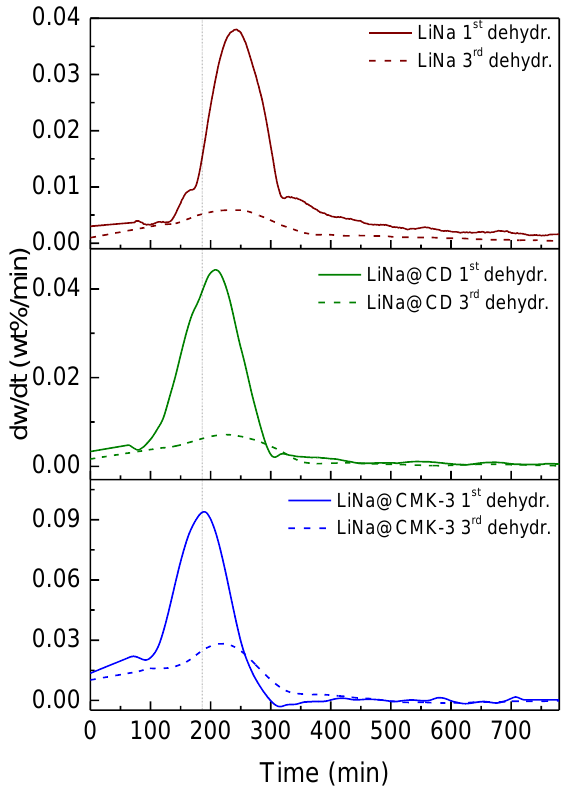
Figure 6. Derivative curves of the H 2 release versus time measured with a manometric device (Sieverts method, data shown in Figure 5) for LiNa (dark red), LiNa/CD (green) and LiNa/CMK-3 (blue).